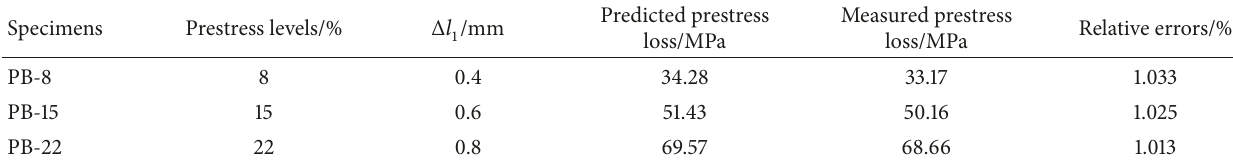
Table 2: Prestress loss by predictions and measurements during tension.